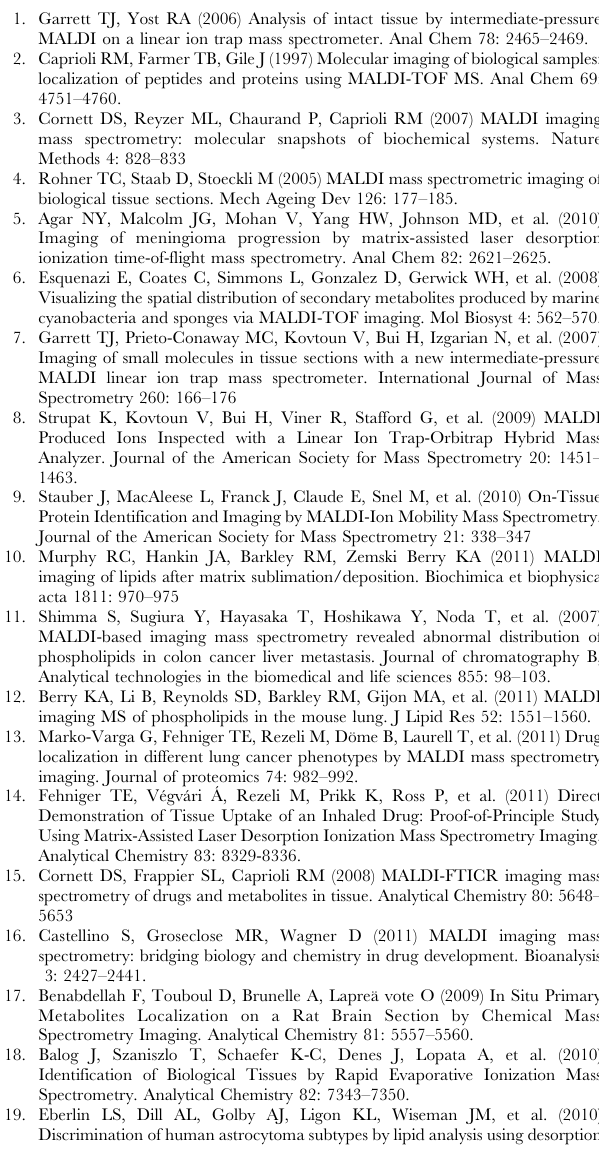
Figure S2 MS/MS spectrum of m/z 802.5 collected from the Waters